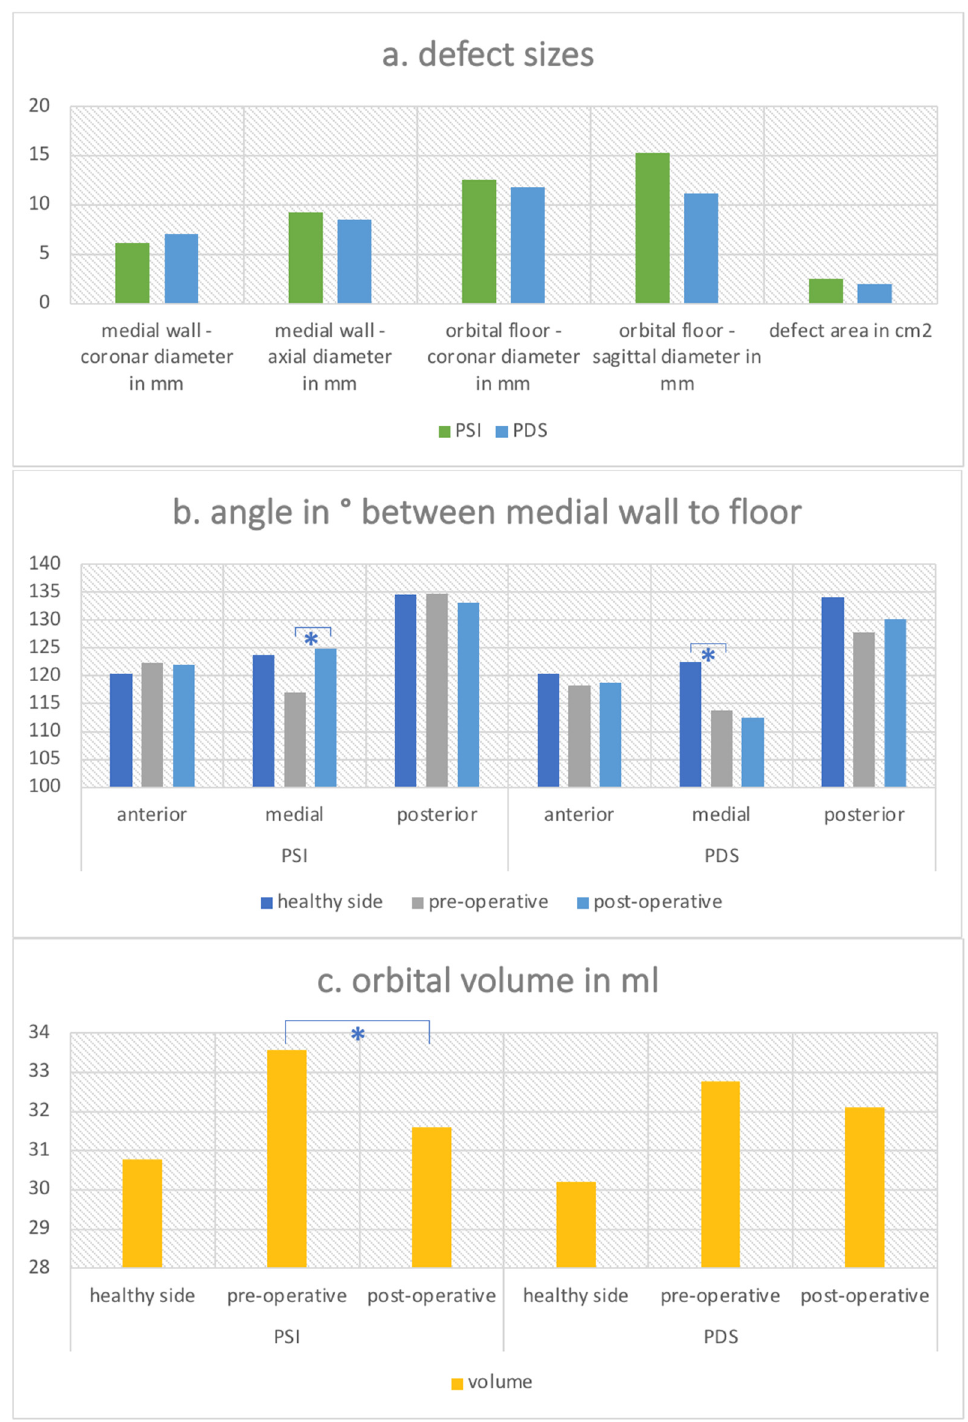
Figure 7. Radiological parameters in two-wall orbital fracture. ( a ) Defect sizes for the different study groups “PSI” versus “PDS”. Two diameters in mm are displayed for each medial wall defect and the floor defect as well as the overall defect area in cm 2 . ( b ) Angles in ° are displayed for each study group “PSI” versus “PDS” measured in the anterior, medial and posterior part of the orbit for the healthy unaffected side as well as the fractured side pre- and post-operatively. * indicates significance with p < 0.05. ( c ) Orbital volume in ml for the different study groups “PSI” versus “PDS”measured for the healthy unaffected side as well as the fractured side pre- and post-operatively. * indicates significance with p < 0.05.